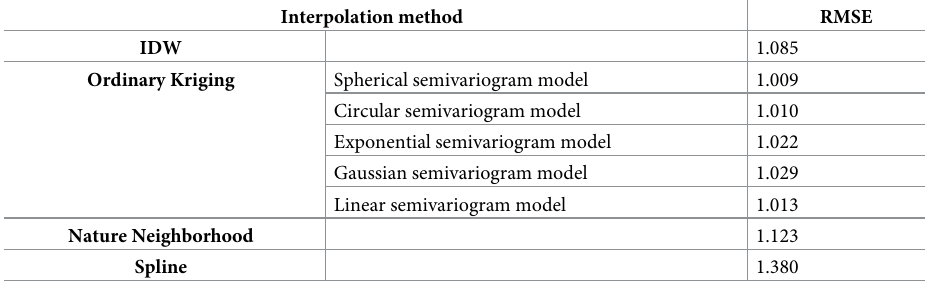
Table 6. An estimation of RMSE corresponding to interpolation